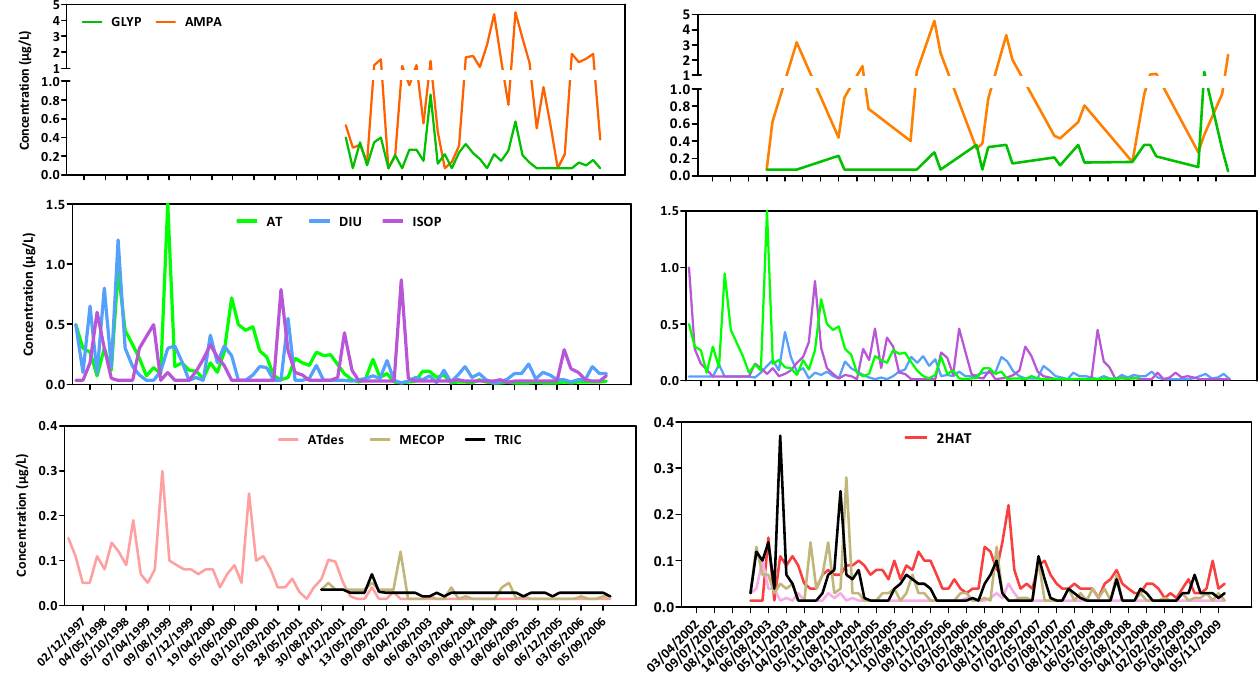
Figure 3. Evolution of pesticides on V8 ( left ) and M12 ( right ) (historical data